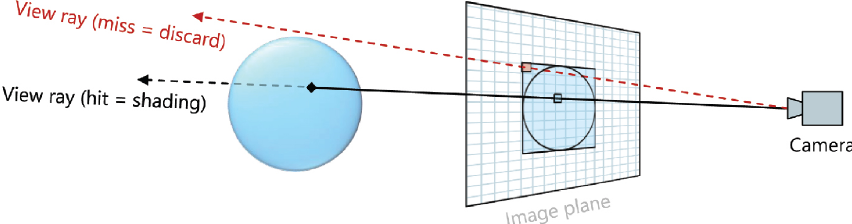
Figure 2: Schematic drawing of GPU-based raycasting: for each sphere, a proxy geometry that covers the whole sphere is rendered (blue quad in the image plane). For each fragment of this quad, a view ray is computed in the pixel shader and a ray-sphere intersection determines whether the actual sphere is visible through this pixel. Our objective is to assess the rendering speed of the custom GPU used by HoloLens for such shader-based methods. We also compare this approach to traditional rendering methods based on triangle